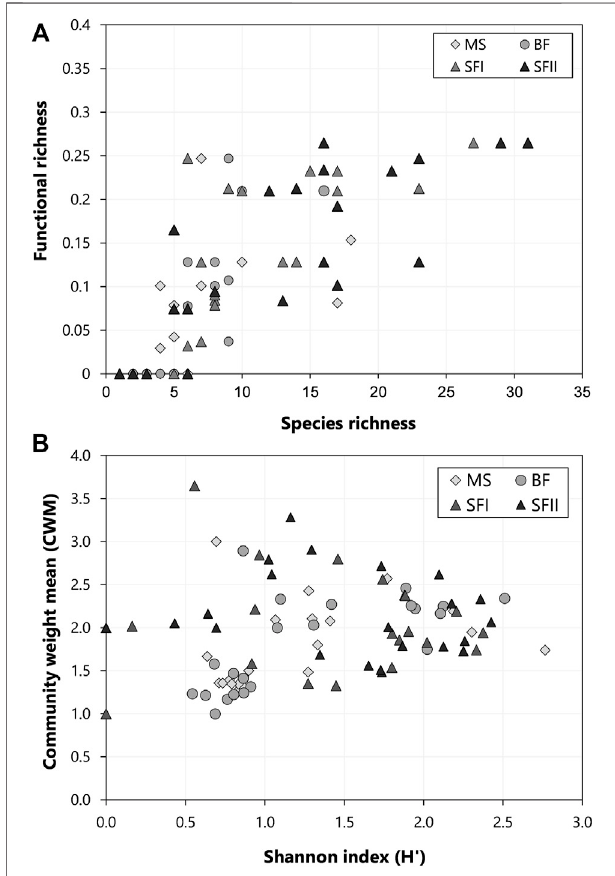
Frontiers in Environmental Science |